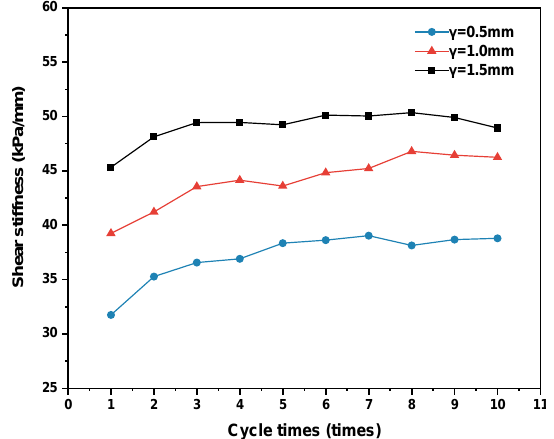
Figure 18. Development trends of shear stiffness with different shear amplitudes.